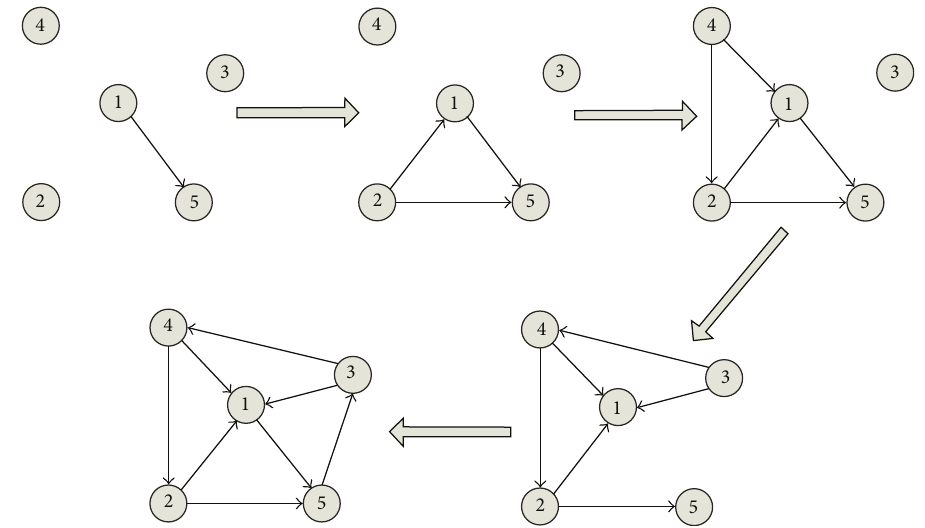
Figure 9: Formation based on the operation of adding a vertex.